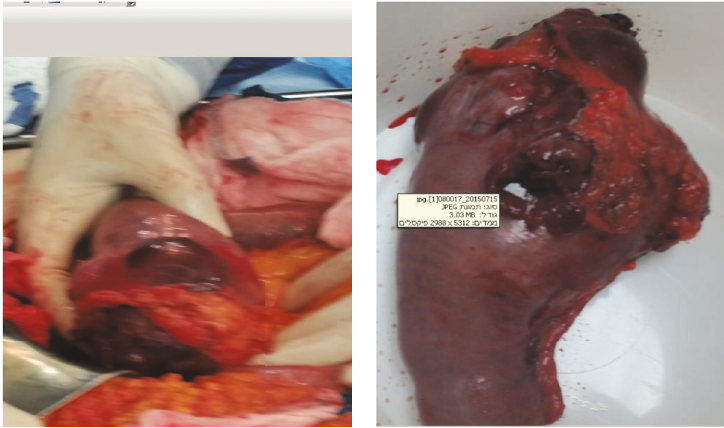
Figure 2: At laparotomy: mass at proximal jejunum with blowout perforation of 1cm on the lateral wall of the